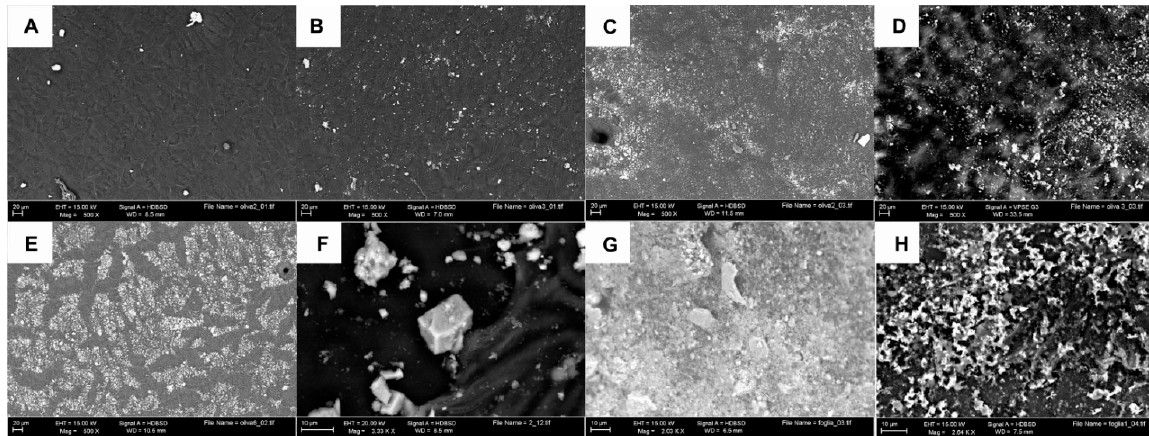
Figure 3. ESEM observations of treated and untreated olives. ( A ) Untreated (T) olive surface; ( B ) Olive surface treated with CHA-zeolitite (Z treatment, first application); ( C ) Olive surface treated with kaolin (K treatment, first application); ( D ) Olive surface treated with CHA-zeolitite (Z treatment, last application); ( E ) Olive surface treated with kaolin (K treatment, last application); ( F ) Morphology of CHA-zeolitite particles; ( G ) Morphology of kaolin particles; ( H ) Olive surface where kaolin appears to be incorporated by waxes.